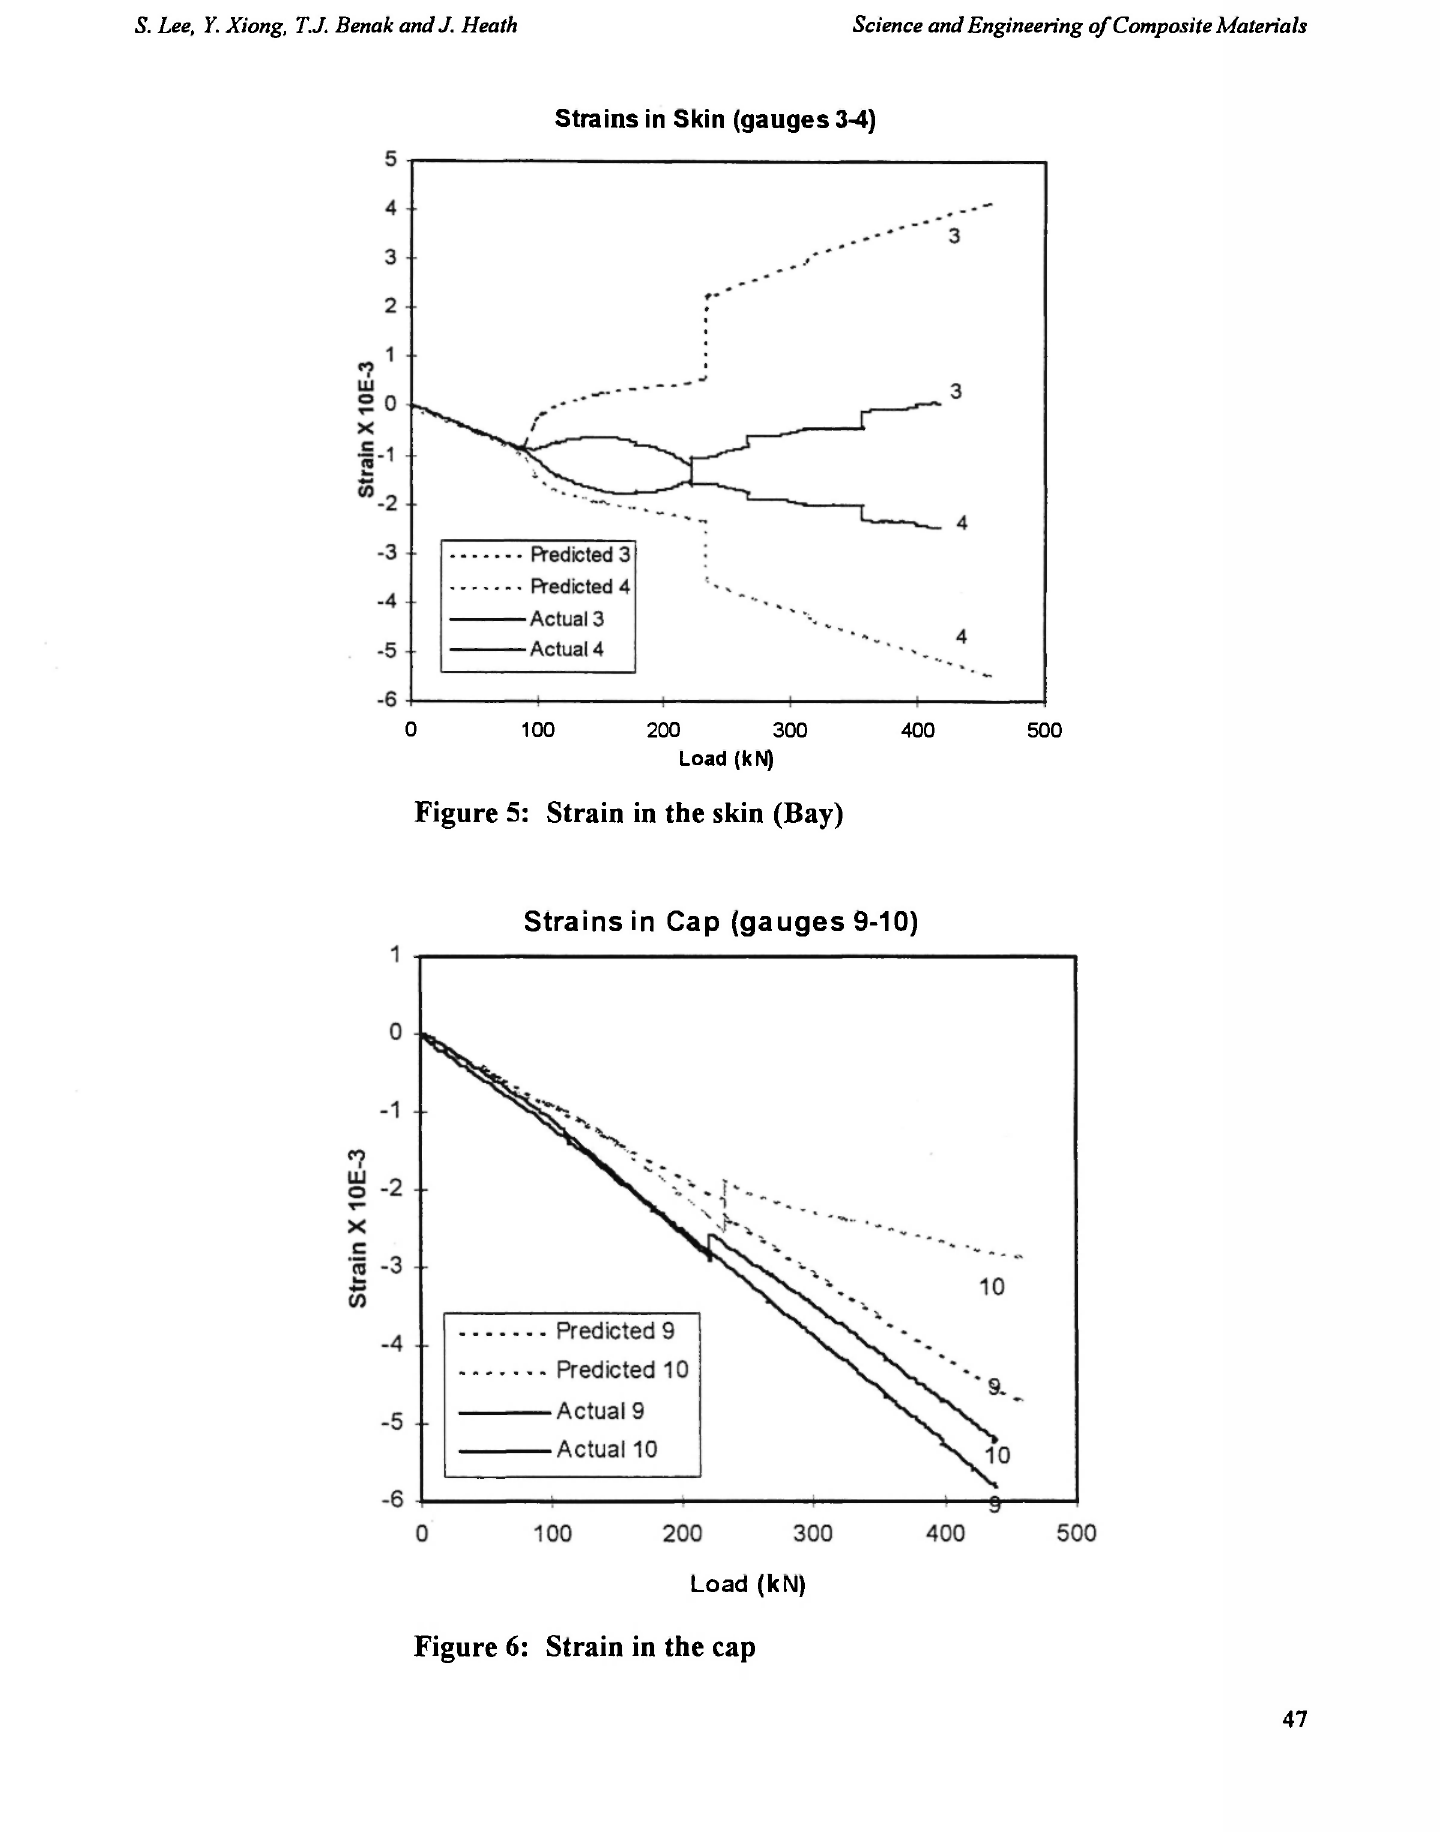
Figure 5: Strain in the skin (Bay)